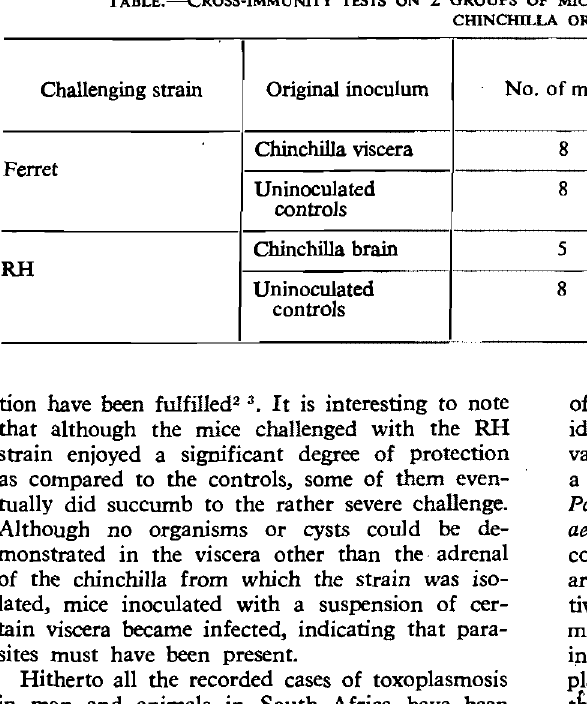
TABLE.---CROSS-IMMUNITY TESTS ON 2 GROUPS OF MICE INOCULATED SIX WEEKS PREVIOUSLY WI11f CHINCHILLA